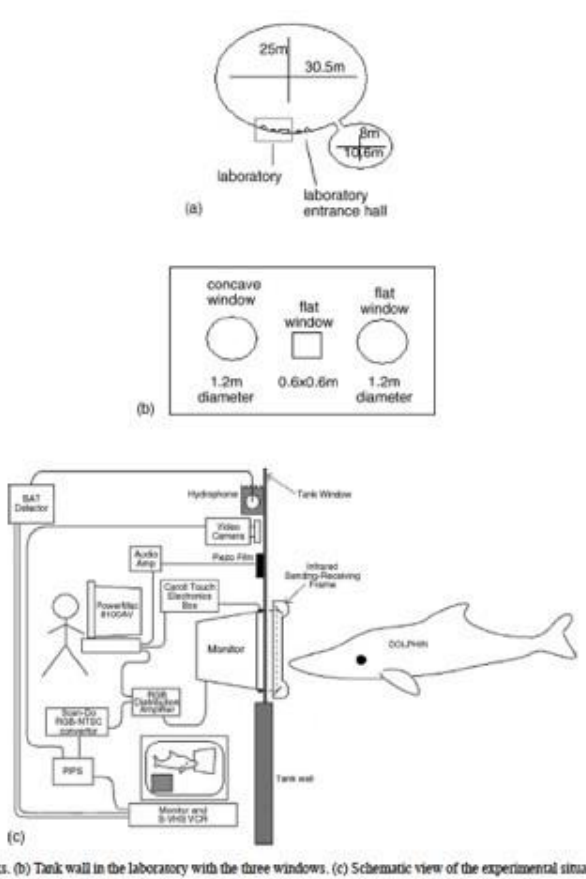
Figure 3. Underwater touchscreen using infrared touch used at Sealife Park, Oahu, Hawaii. Reprinted with permission from Elsevier: Behavioural Processes